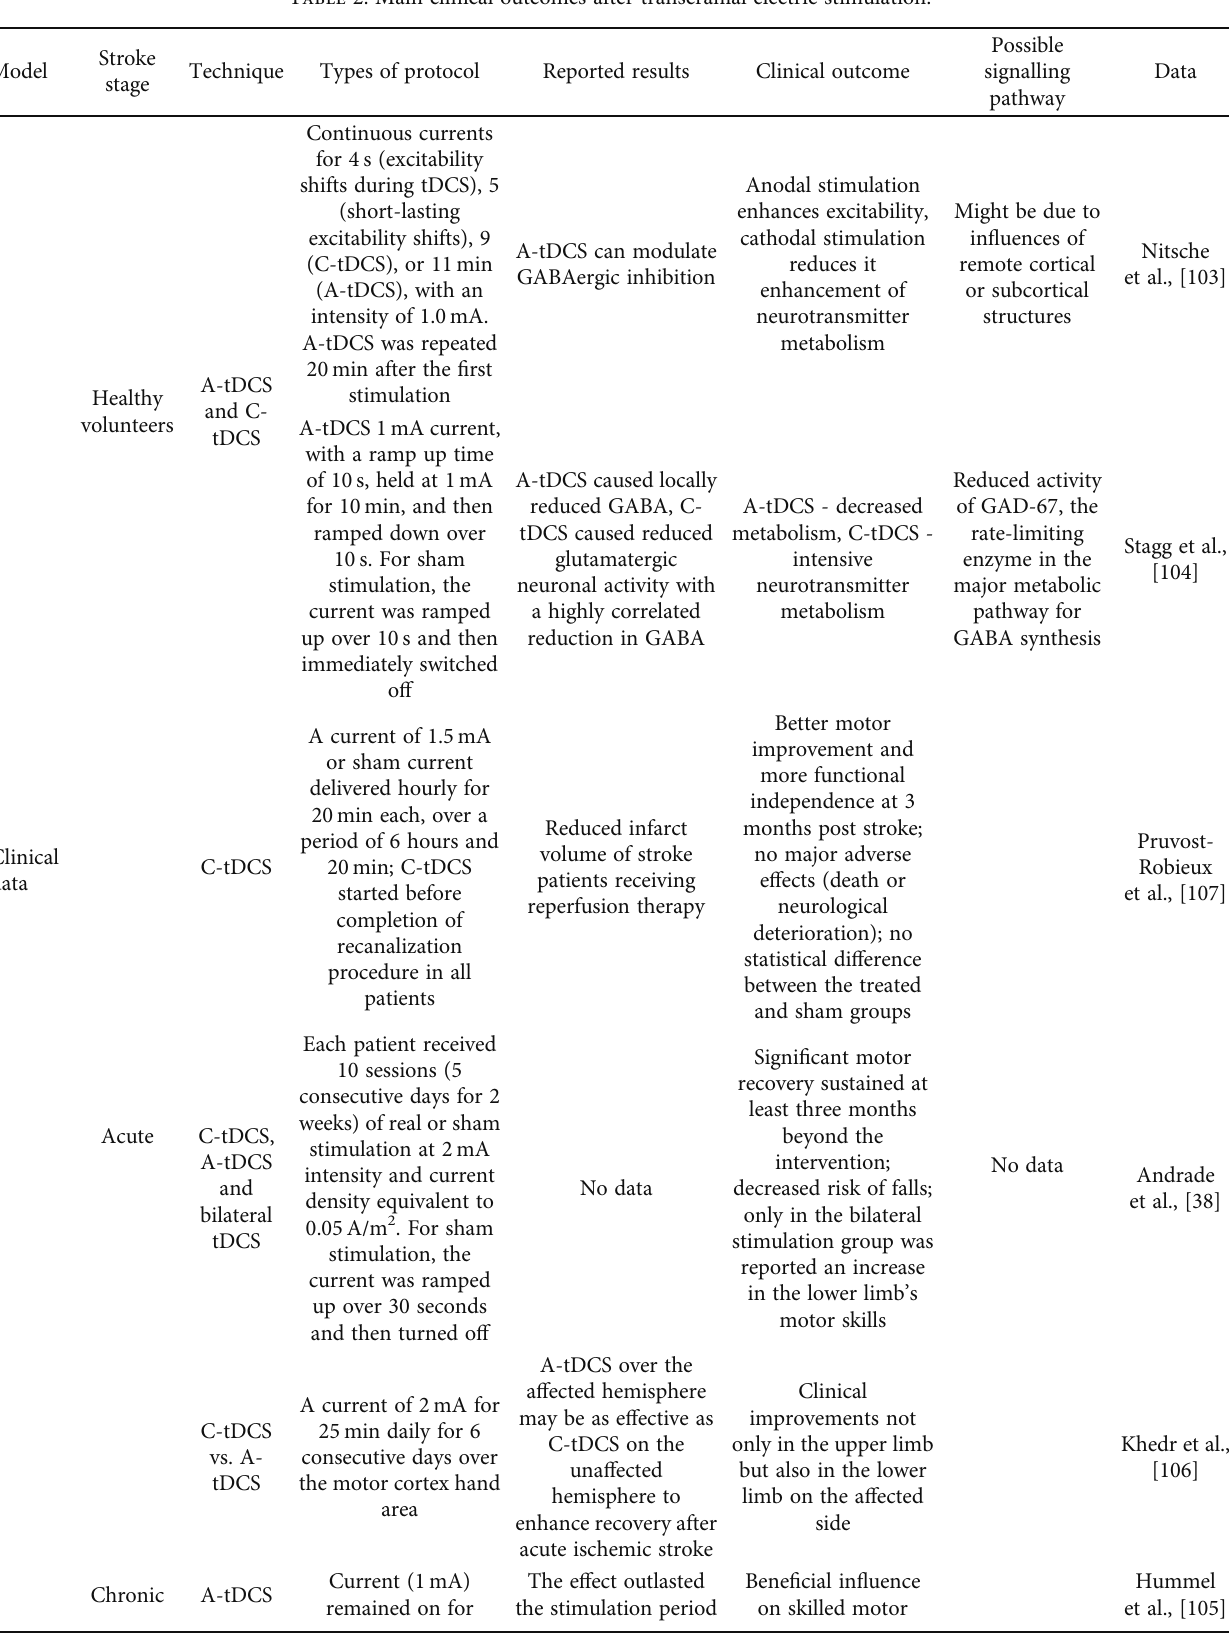
Table 2: Main clinical outcomes after transcranial electric